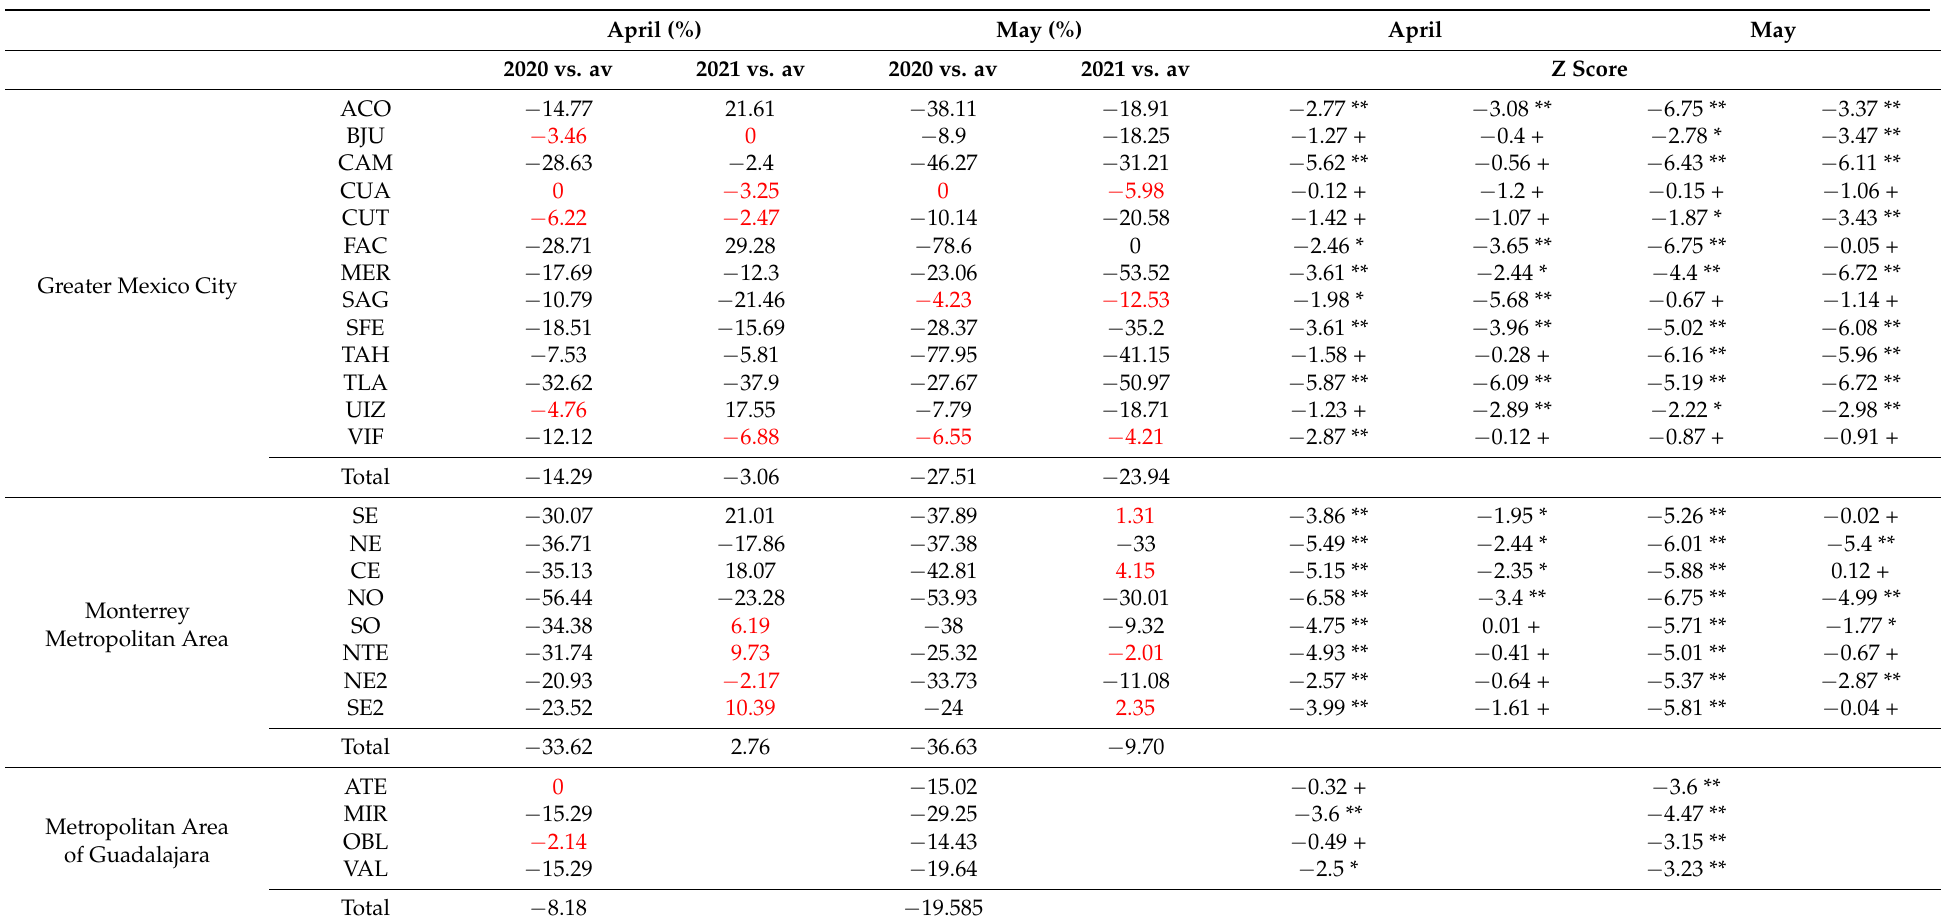
Table 2. Changes in PM 10 concentrations (%) in April and May 2020 and 2021 in GMC, MTY, and MAG. Red numbers indicate not statistically significant